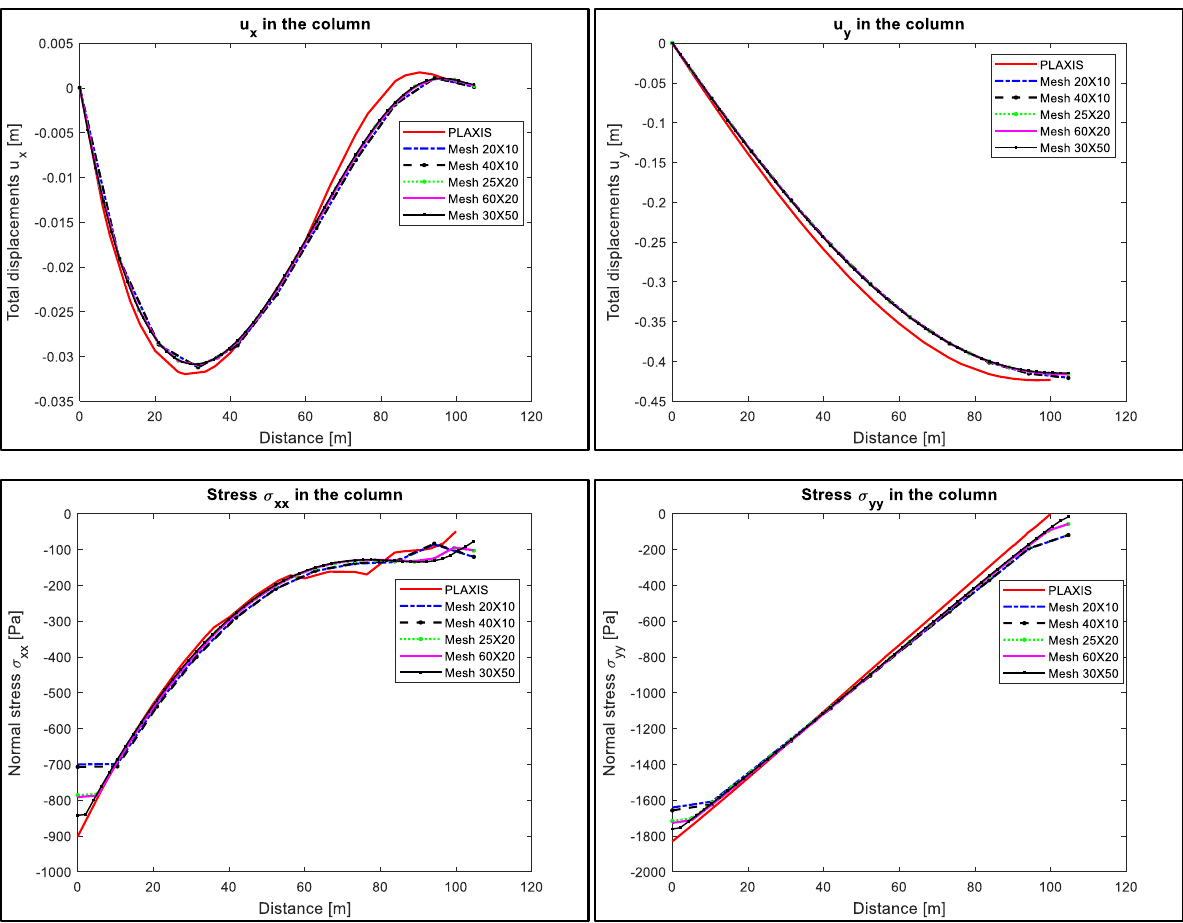
Figure 11. Displacements and stresses in the column considered for Matlab and PLAXIS models according to mesh size.